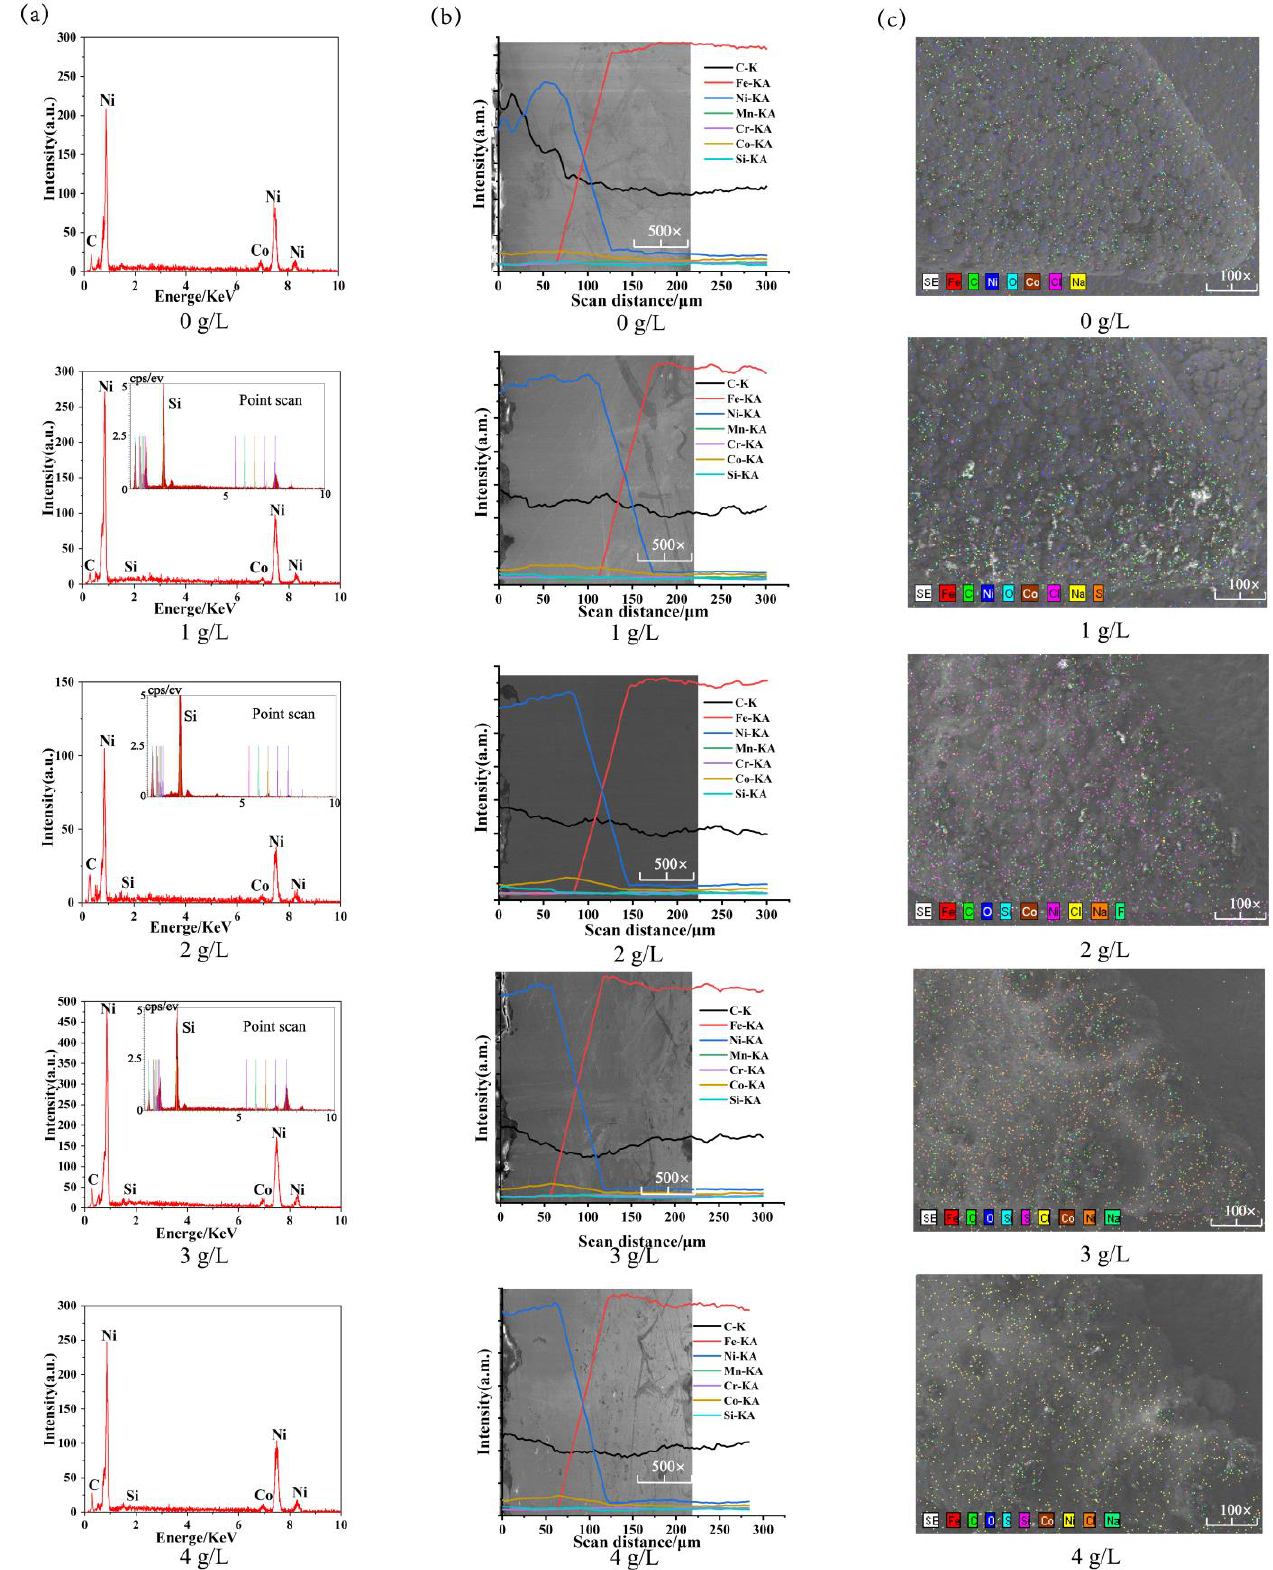
Figure 5. EDS spectroscopic analysis of Ni-Co- β -SiC coatings prepared with different SiC concen- trations: ( a ) selected area scanning on the surface of the spindle hook tooth, ( b ) cross-sectional line scanning, and ( c ) scanning on the surface of the spindle hook tooth.